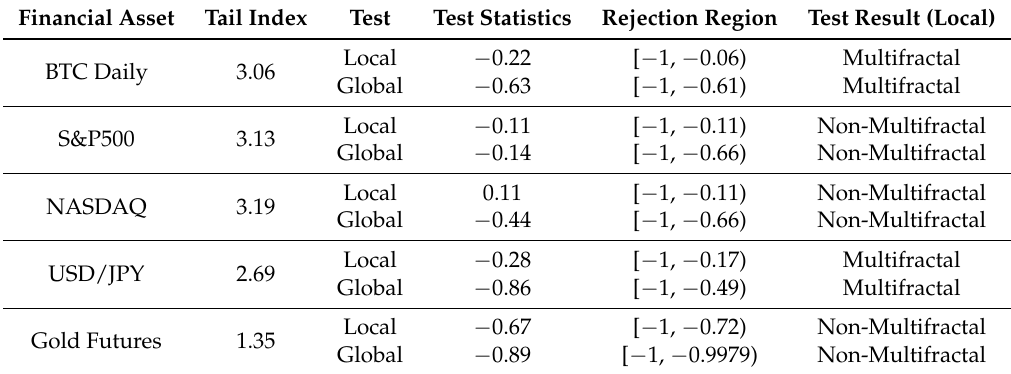
Table 5. Test results among different financial assets (28 April 2013–3 September 2019).